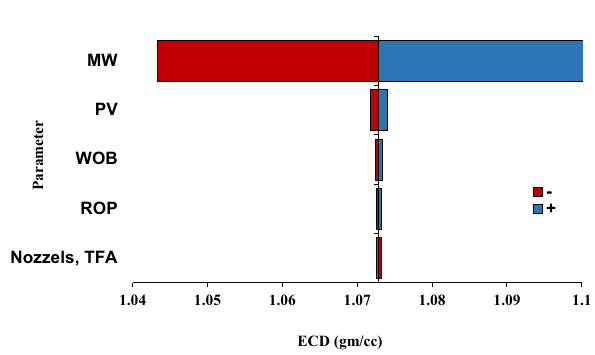
Fig. 20 Percent of variation explained by each factor for X -variables (ECD model)